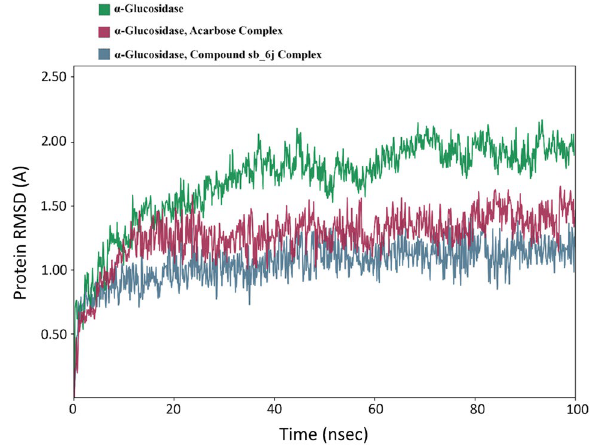
Figure 6. The RMSD values of the α-glucosidase apo-enzyme (green), acarbose in complex with the α-glucosidase enzyme (red), and compound 6j in complex with the α-glucosidase enzyme (blue).